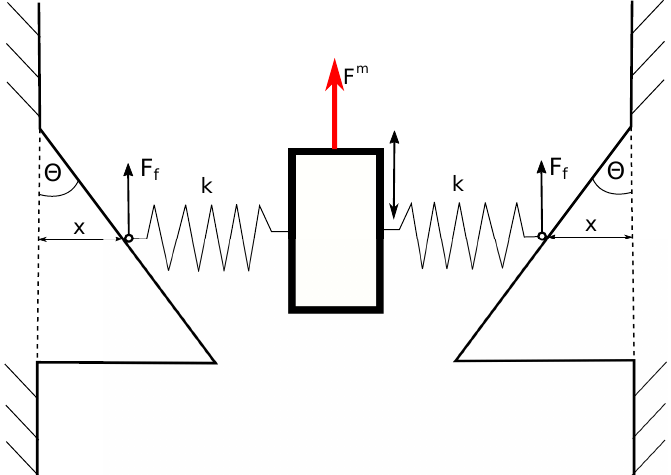
Figure 23. Mechanical model of plug insertion experimental